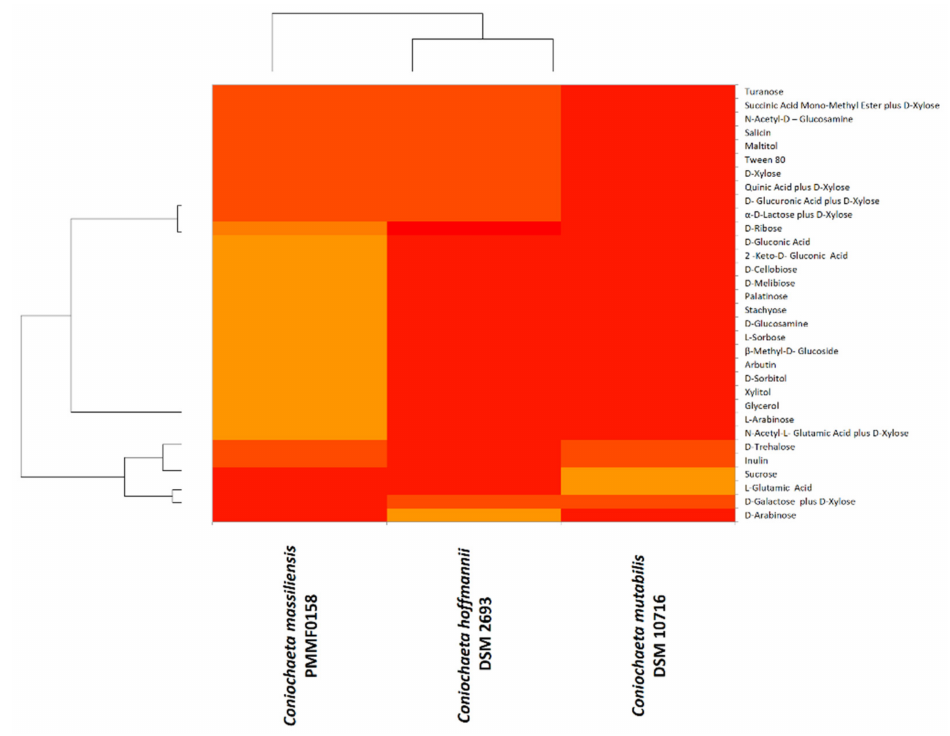
Figure 4. Heat map computed with the XLSTAT software for carbon-source oxidation by the Biolog TM system for the novel species Coniochaeta massiliensis (PMML0158) and two reference strains in the genus. Colour-gradient interpretation: the most-oxidized substrates are shown in light orange and the least-oxidized substrates are shown in red.